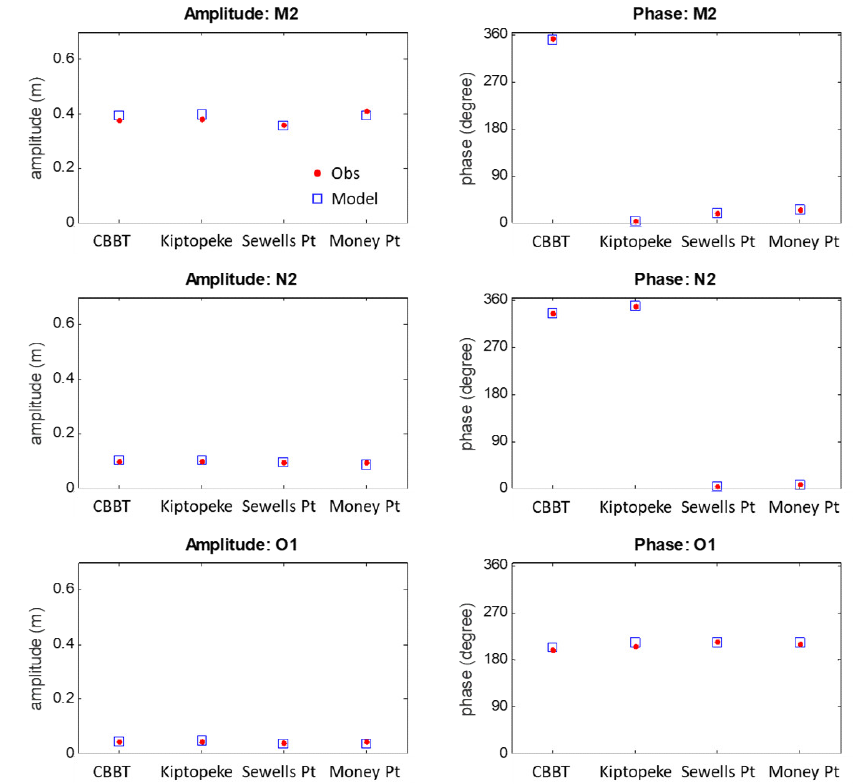
Figure 7. Model-data comparison on major tidal components of the surface elevation at four stations near the project